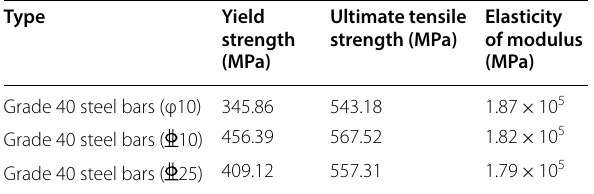
Table 4 Reinforcement properties.